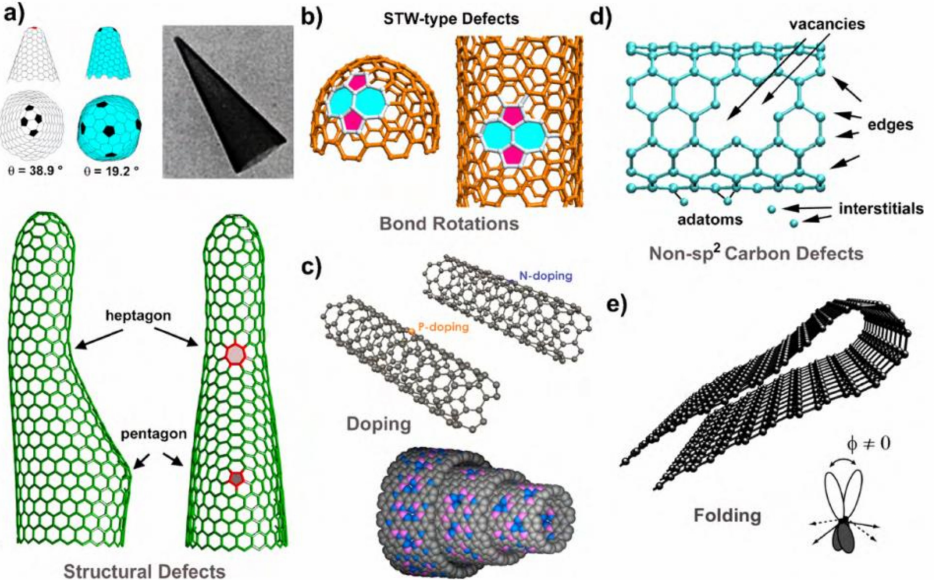
Figure 9. Representations of defects in graphene-like materials using pictorial models. ( a ) defects in the hexagonal sp 2 hybridised carbon lattice, ( b ) Stone–Thrower–Wales defects, ( c ) replacement of carbon with another element inside the hexagonal lattice, ( d ) carbon defects, such as vacancies, edges, adatoms, interstitials, carbon chains, etc., that are not sp 2 hybridised, and ( e ) consequence of considerable deformation of graphene, folding-induced defects. (Reproduced from [199] with permission. Copyright 2010, Elsevier, Amsterdam, The